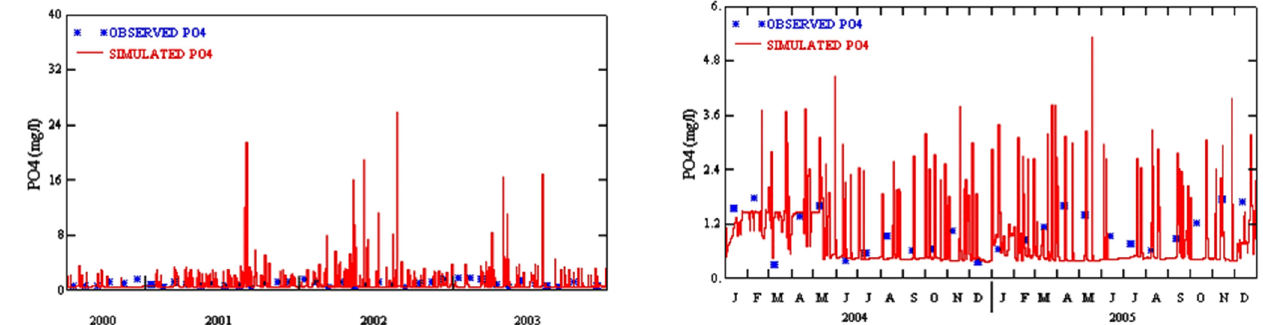
Figure 5. Ortho phosphate calibration and validation.